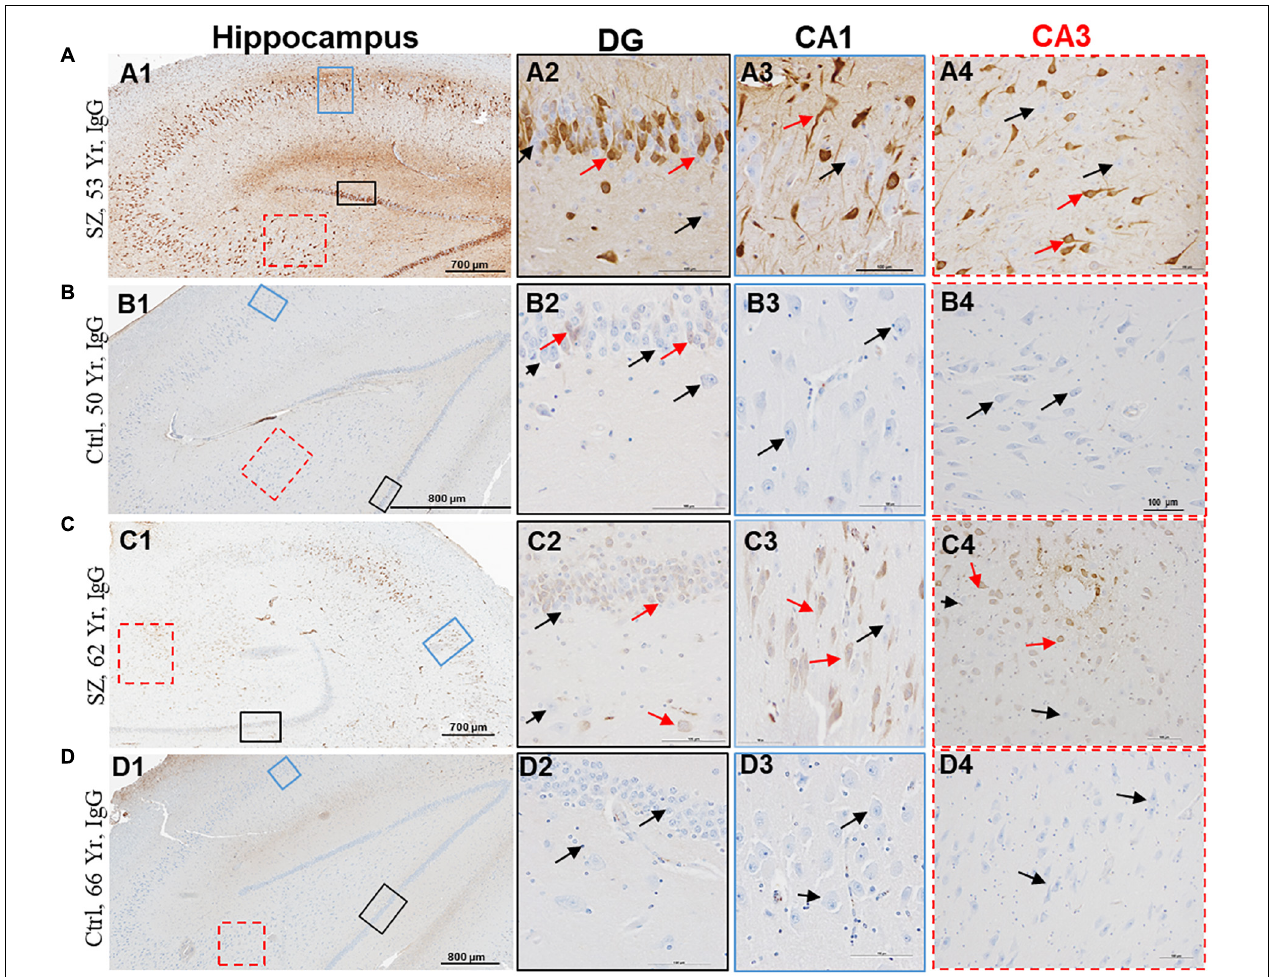
FIGURE 3 | Hippocampus proper of SZ patients demonstrates increased BBB permeability and selective interaction between IgGs and neurons. (A–D) Representative immunohistochemistry images showing the detection of extravasated IgGs (brown color) in the parenchyma of hippocampus proper from SZ and Ctrl subjects. Sections were probed with biotinylated anti-human IgG antibodies. Once in the brain parenchyma, IgGs selectively interacted with neuropil and a subset of neurons. A subset of neurons within the DG, CA1, CA2, and CA3 regions of hippocampus demonstrated selective immunoreactivity for IgGs (red arrows). The neurons without IgG immunoreactivity are denoted by black arrows. DG = dentate gyrus; CA = Cornu Ammonis. Scale bar (in µ m): A = 700 and 100; B = 800 and 100; C = 700 and 100; and D = 800 and